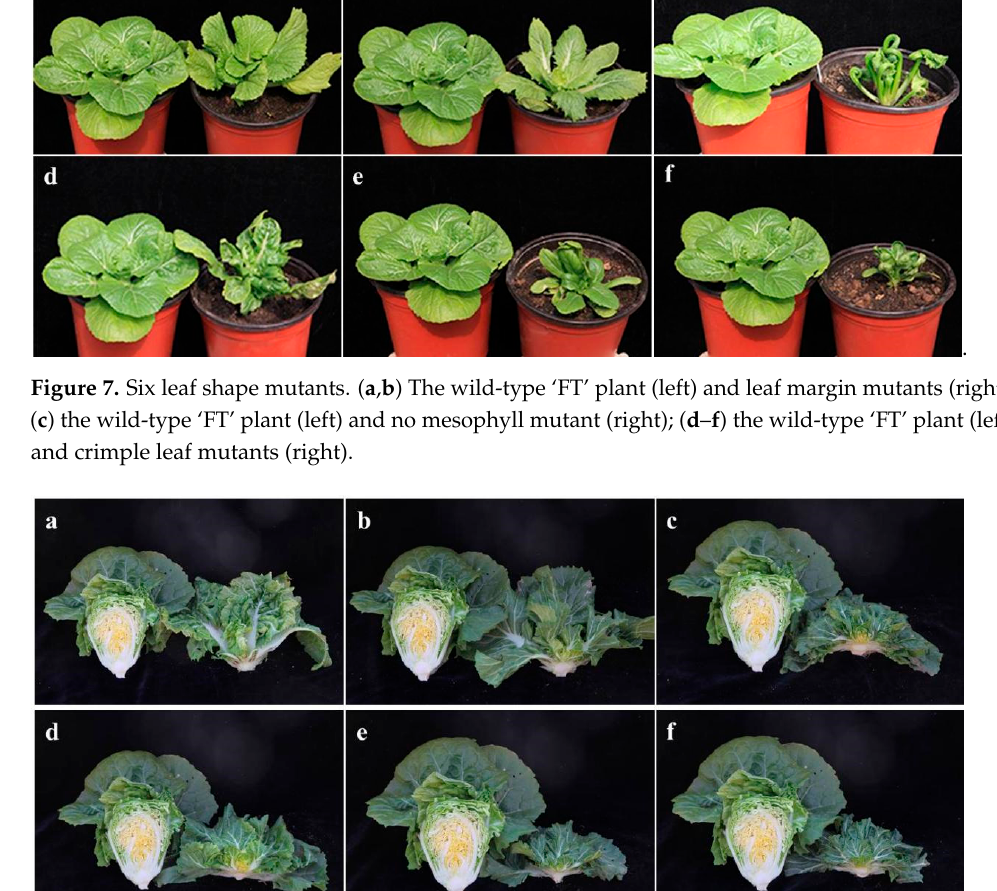
Figure 8. Six leafy head mutants. ( a – f ) The wild-type ‘FT’ plants (left) and non-heading mutants (right). A total of 16 early-bolting mutants were observed (Figure 9 right), and the flowering time was about 25 days earlier than the wild-type ‘FT’ plants.